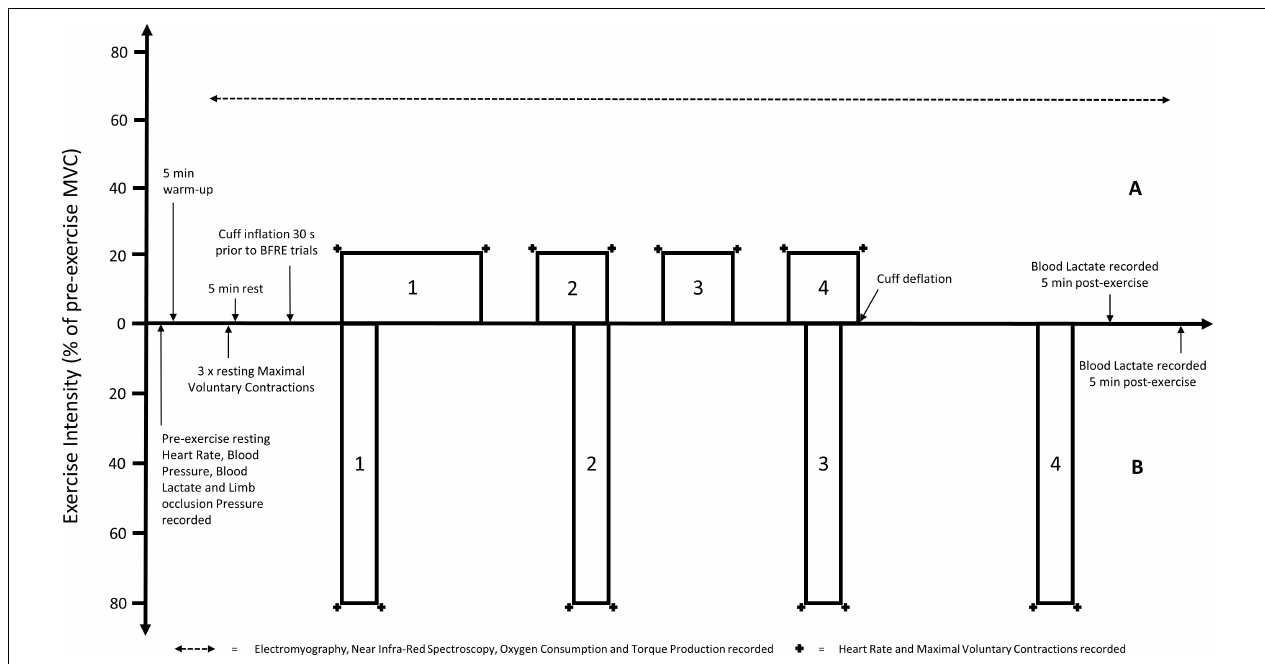
FIGURE 1 | Visual representation of the timing and intensity [based on pre-exercise maximal voluntary contraction (MVC)] of the (A) light load resistance exercise trials [including all blood flow restriction exercise (BFRE) trials] and (B) heavy load resistance exercise trial. Note that the pre- and post-exercise measurements are not to